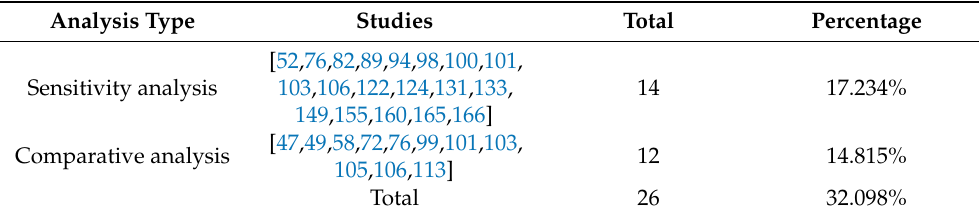
Table 7. Distribution of papers based on sensitive and comparative